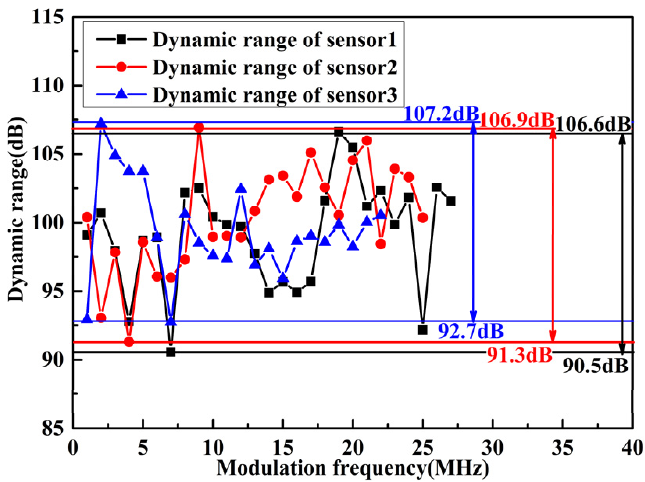
Figure 13. The dynamic range of the FOASs based on the FPEs with different Q factors under the modulation frequency from 1 MHz to 27 MHz.